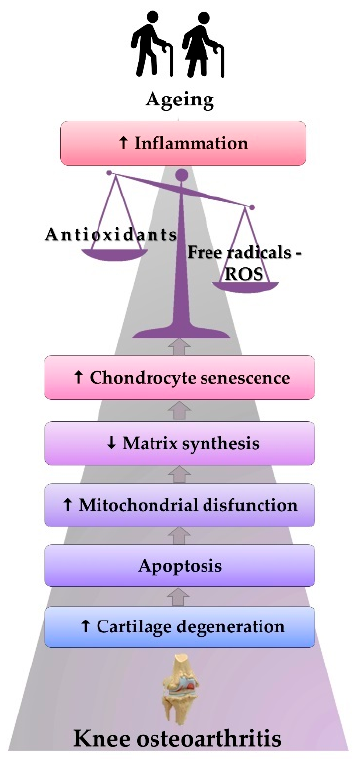
Figure 3. The physiopathological mechanism of ROS-induced KOA. Figure 3 features KOA stages among older adults: aging is correlated with the effects generated by the increase in the inflammatory status and oxidative stress. Such stress causes the onset of mitochondrial dysfunctions and a decrease in matrix synthesis. All the alterations accelerate chondrocytes’ senescence, leading to apoptosis, cartilage degenera- tion, and the beginning of KOA.